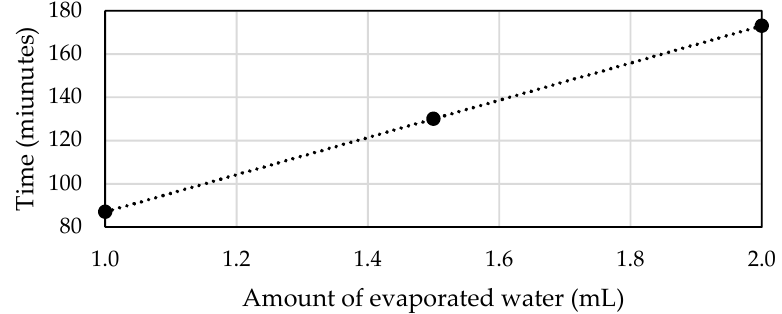
Figure 15. Trend line from defogging time of all three experiments.